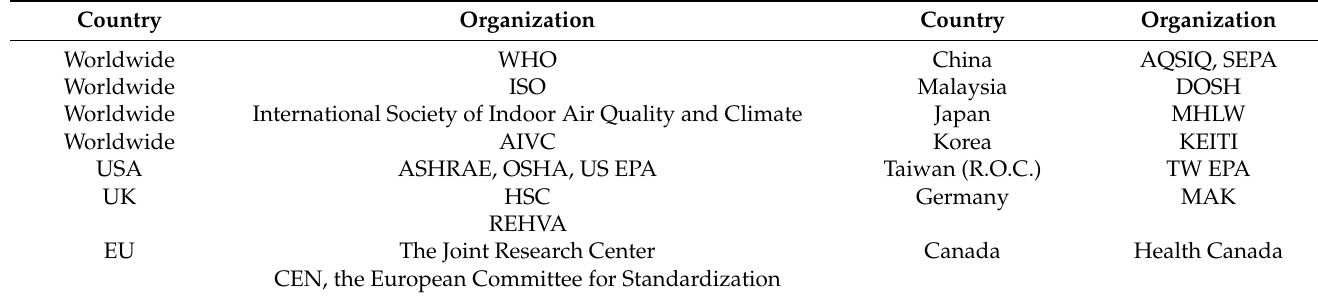
Table 1. Countries and organizations working on